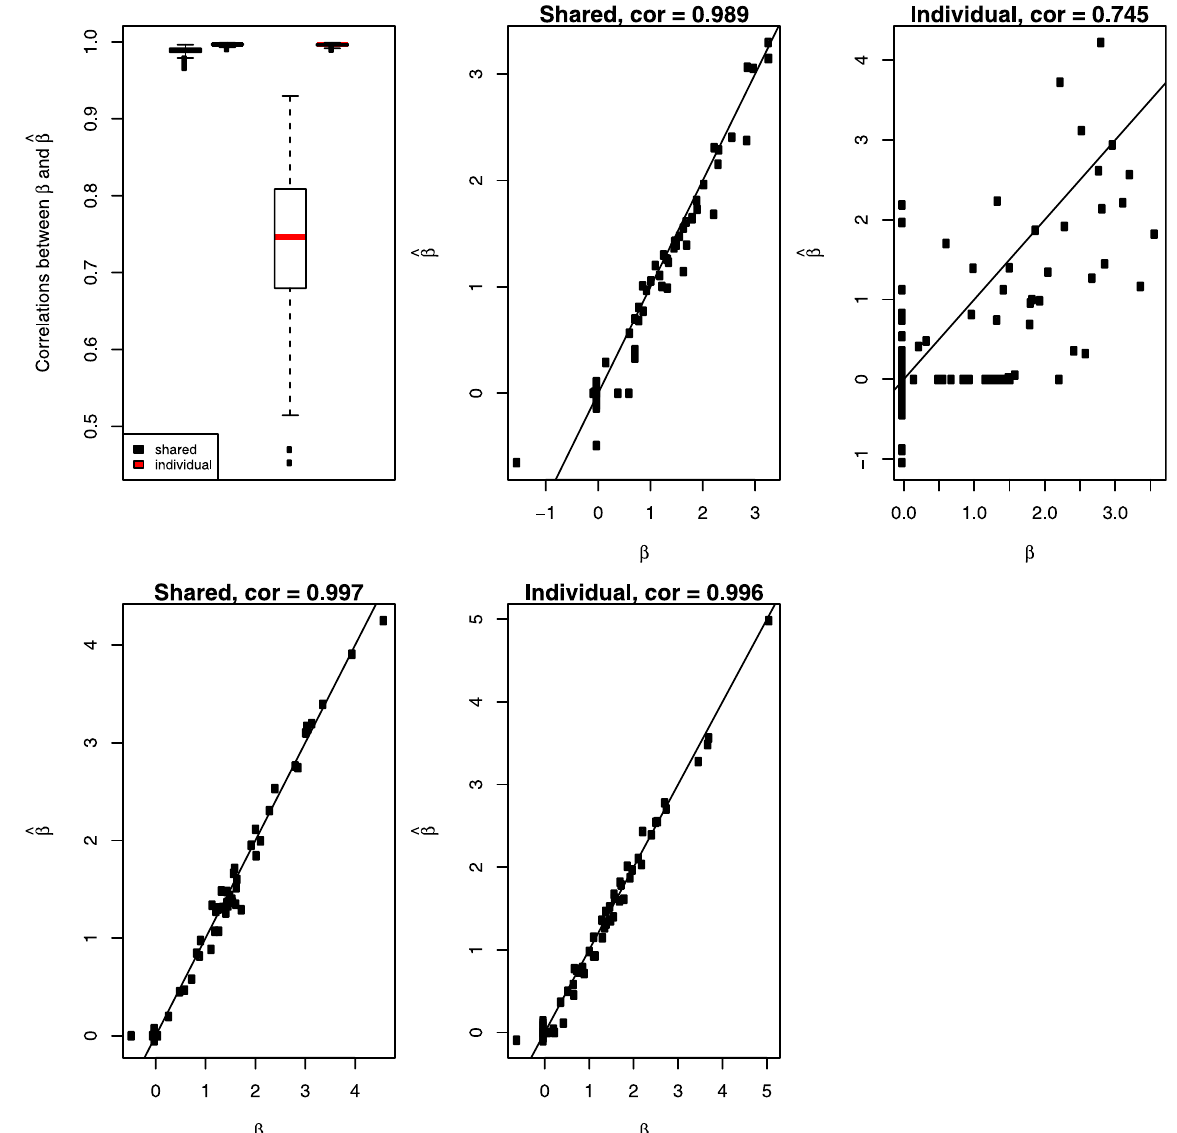
Figure 4. Top left panel: Simulation correlations between estimated β and the true β across the 200 runs of the simulation for the shared model (black) and extracted from fitted individual models (red). The side by side boxplots represents the two different sample sizes in the simulation. All other panels show the scatterplots of estimated values of β versus true values at the median correlations from the boxplots in the top left